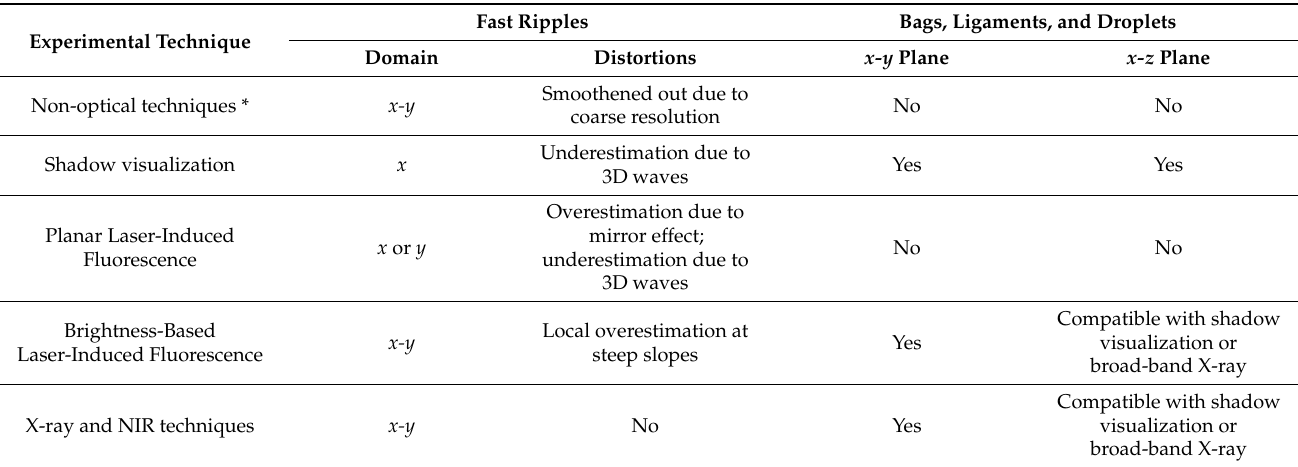
Table 1. Summary of limitations and capabilities of experimental techniques related to investigation of entrainment